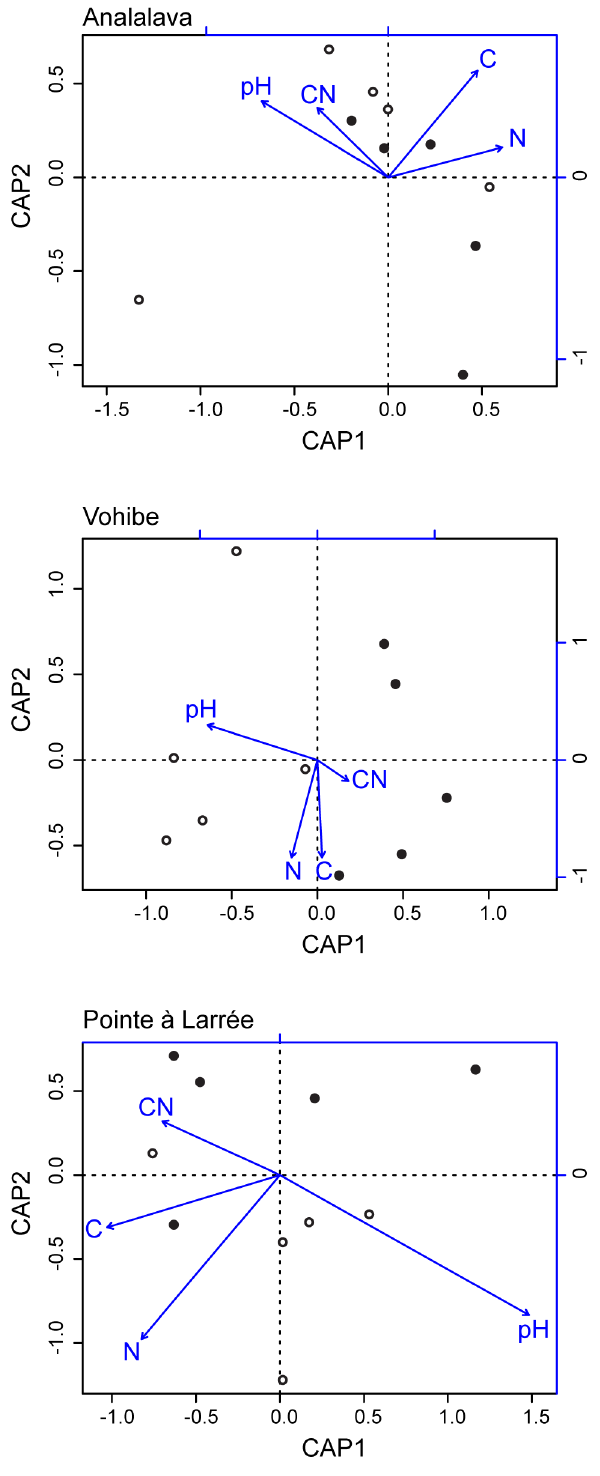
Figure 5. CAP ordination biplots of the bacterial community composition data and soil chemical properties (arrows) within each forest. Closed circles indicate sites from the lower disturbance plot and open circles indicate sites from the higher disturbance plot.